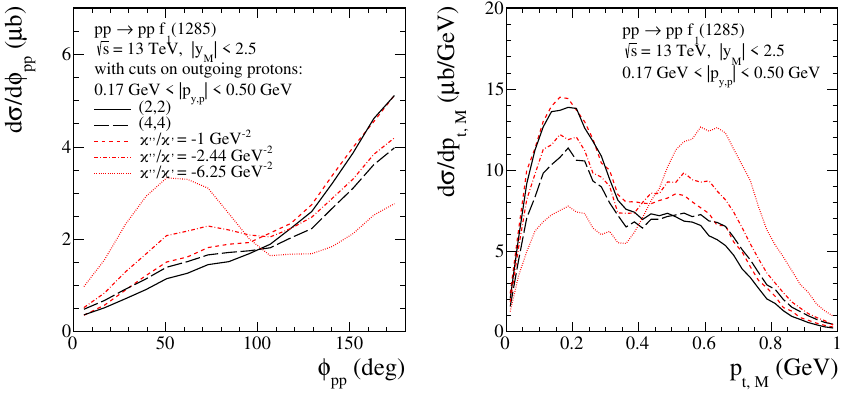
( 1285 ) production at 1